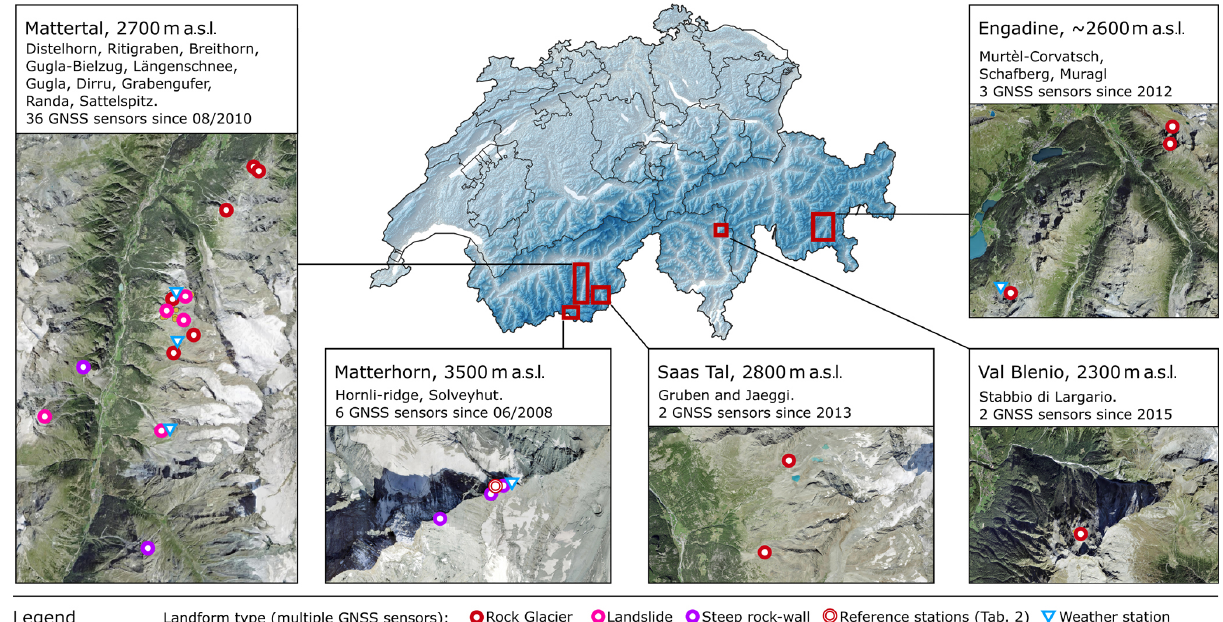
Figure 2. Overview map of the field sites. The field sites are divided into five major geographical and geomorphological areas, for which a panel provides a more detailed sight of the sensor network. Further details can be investigated in the Supplement of the paper. Satellite imagery from the Swiss Federal Office of Topography,